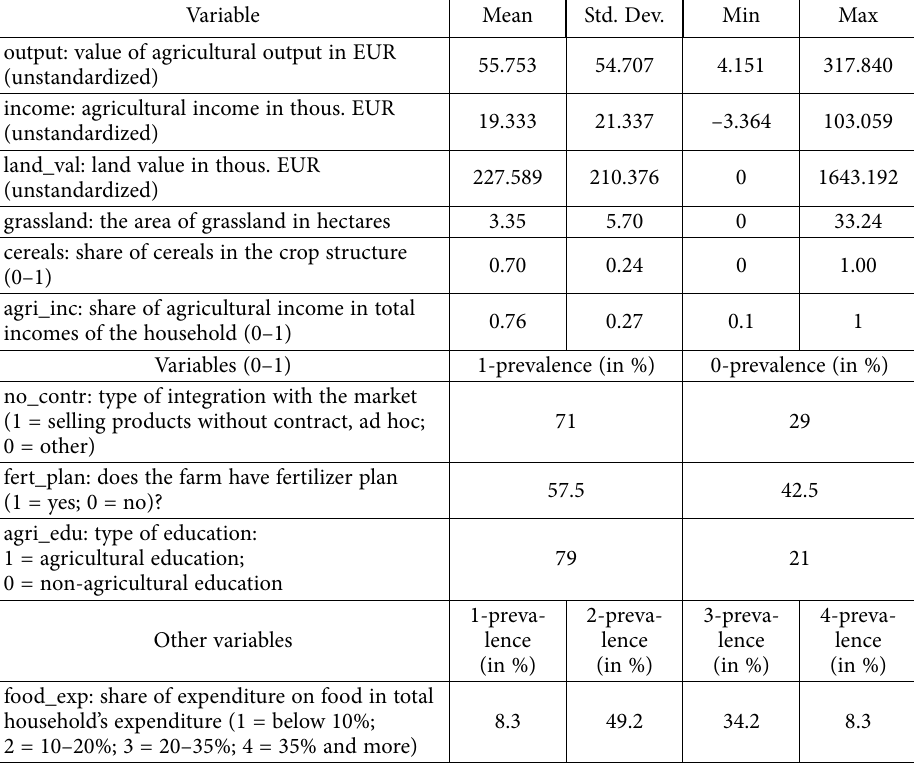
Table 2. Selected descriptive statistics of the agricultural holdings in the Wielkopolska region surveyed in 2018 Variable Mean Std. Dev. Min Max output: value of agricultural output in EUR 55.753 54.707 4.151 317.840 (unstandardized) 19.333 21.337 –3.364